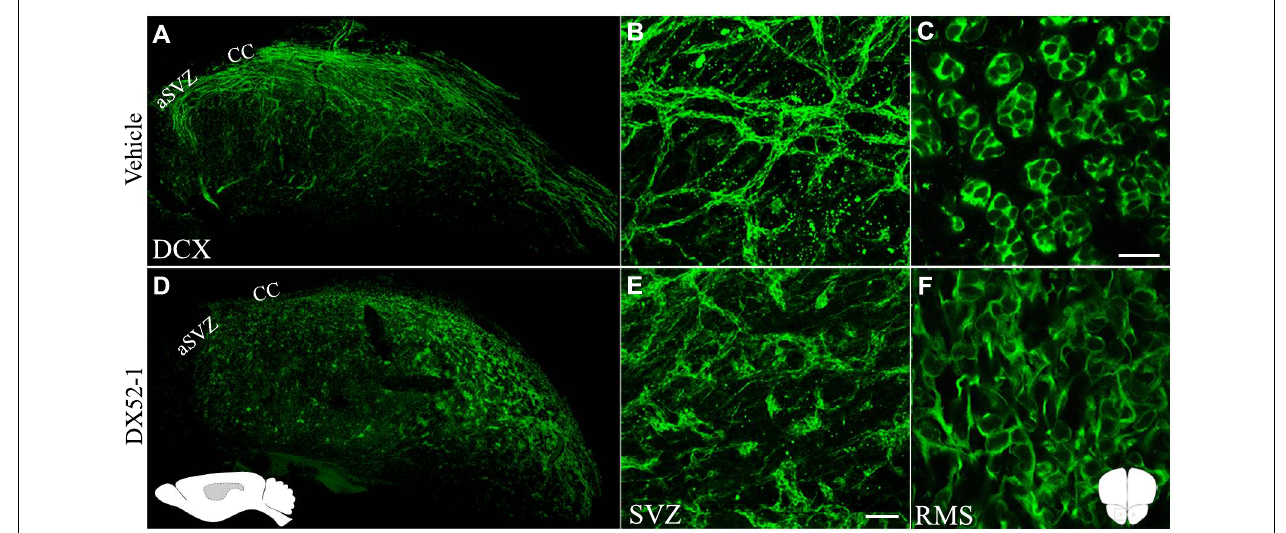
FIGURE 4 |Aberrant morphology of neuroblastsin the SVZ and RMS after radixin inhibition. Overview (A) and magnification (B) of whole mount preparations of the lateral ventricular wall stained for DCX in control animals showing long and well organized neuroblast chains. (C) The RMS in a coronal section showing the tight association of DCX + neuroblasts within cellular chains in control animals. Overview (D) and magnification (E) of whole mount preparations of the lateral ventricular wall stained for